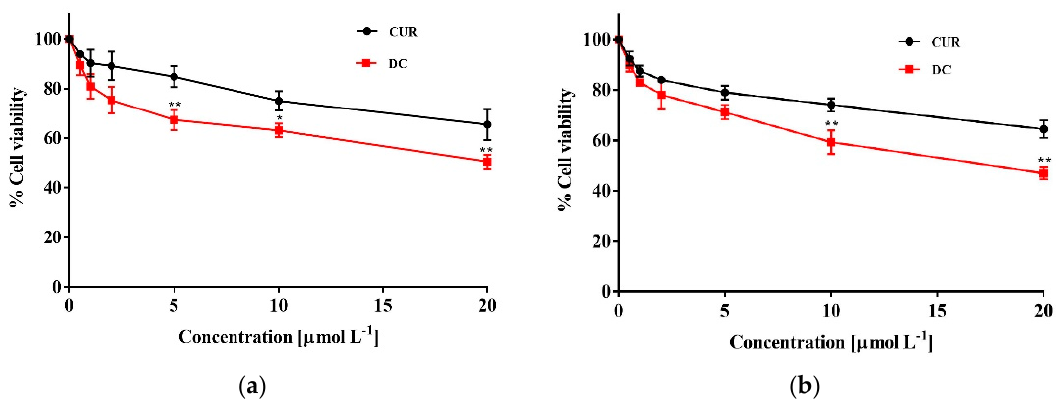
Figure 5. MCF-7 cells treated with increasing concentrations of CUR and DC for ( a ) 24 h and ( b ) 48 h. * p < 0.01, ** p < 0.001 vs. free CUR at equivalent concentration.